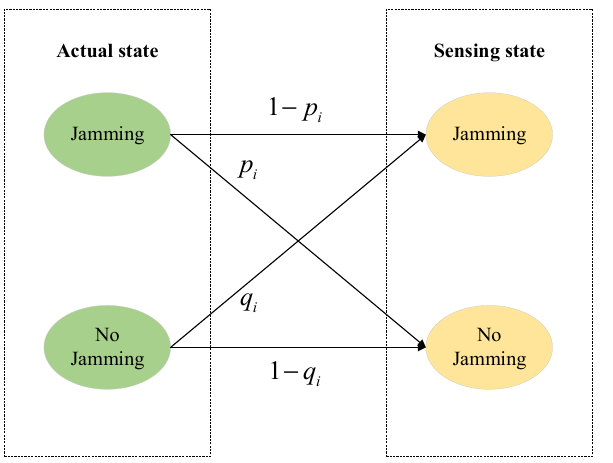
Figure 3. Transition diagram between actual state and observation state caused by false alarm and missed detection.